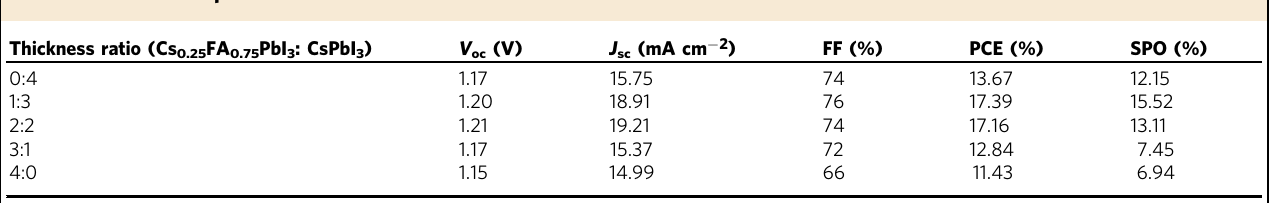
J – V parameters from reverse scans and conversion ef fi ciency of devices with different thickness ratio of Cs 0.25 FA 0.75 PbI 3 layer to CsPbI 3 layer in the perovskite QD